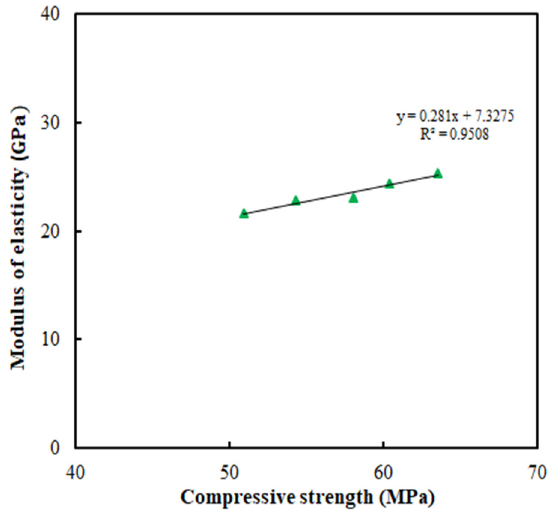
Figure 6. Relationship between compressive strength and modulus of elasticity.